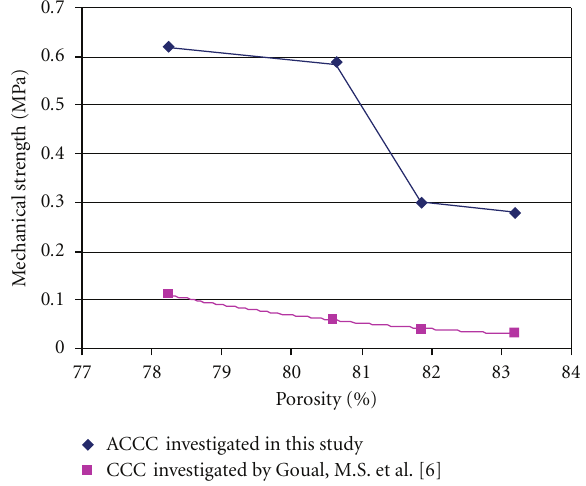
Figure 4: Compressive strength of the ACCC samples investigated in this study and the estimated values based on the literature for CCC [6].